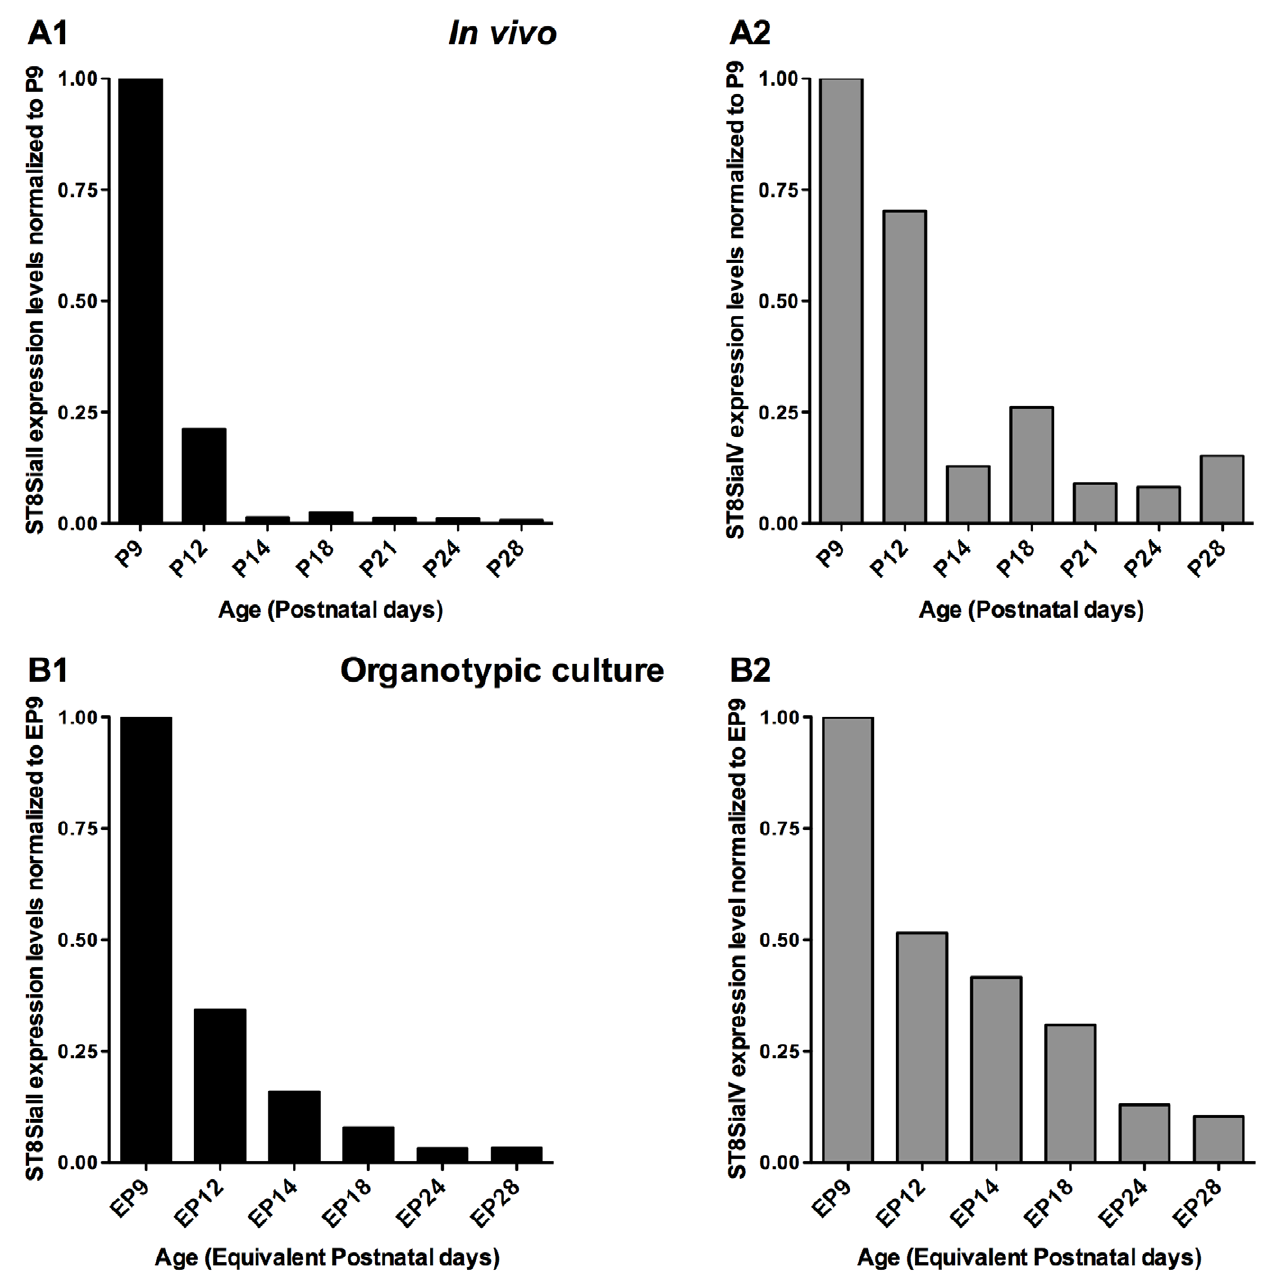
Figure 1. Expression levels of ST8SiaII (black bars) and ST8SiaIV (gray bars) mRNA decline in mouse visual cortex (A) and organotypic culture (B) with a similar time course during postnatal development. ST8SiaII and ST8SiaIV mRNA expression were first normalized to the internal control GAPDH. Bar graph represent the mean of at least two animals (A) or 6 cortical organotypic slices (B), normalized to the value obtained at P9.